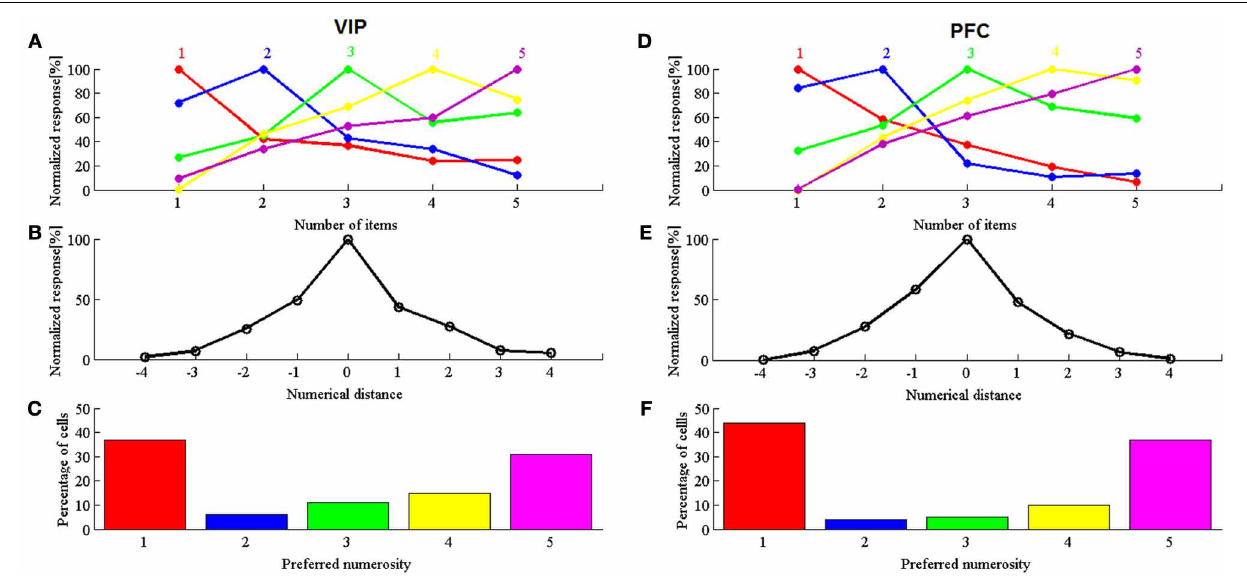
FIGURE 1 | Simulated results. (A,D) Normalized response averaged for neurons preferring a given numerosity in area VIP (A) and in PFC (D) . (B,E) simulated normalized discharge rates of neurons in VIP (B) and PFC (E)